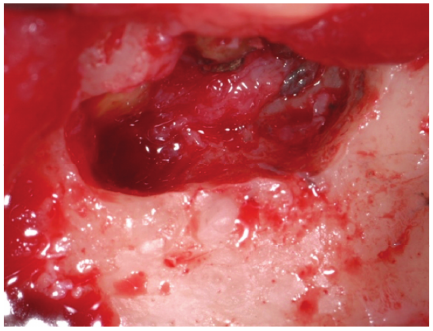
Figure 4: Apicoectomy surgery performed in the symphyseal